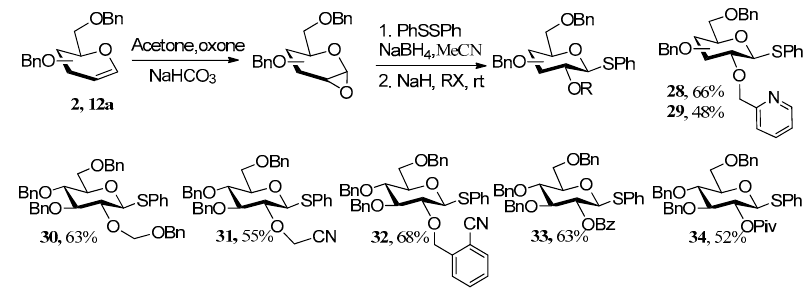
Figure 6. One-pot synthesis of various thioglycoside donors.